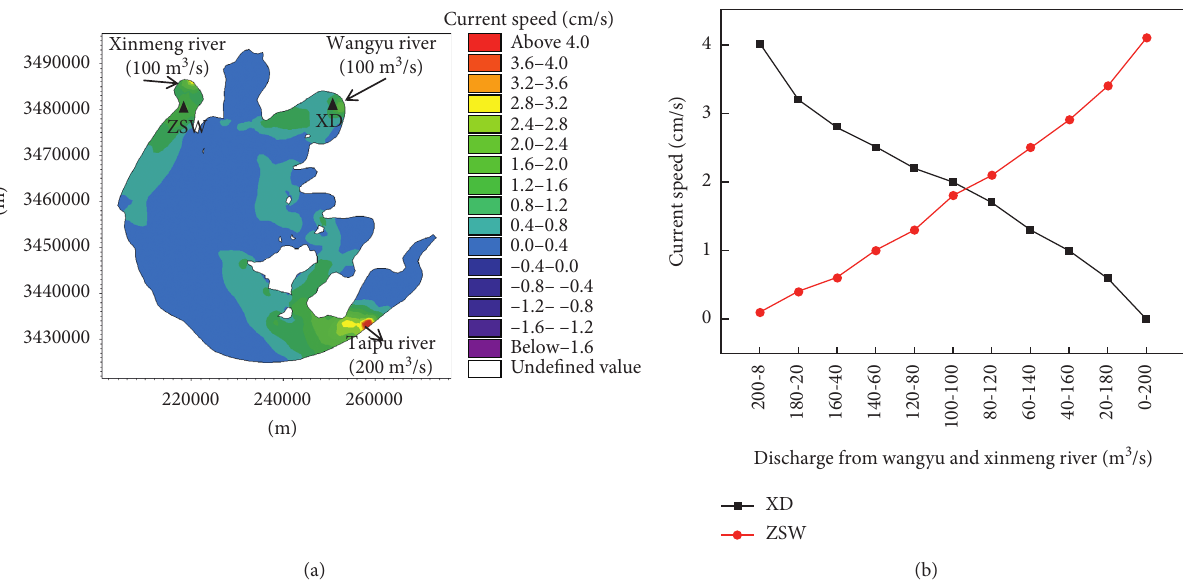
Figure 7: (a) Map of Tai Lake showing the speed of water flow, and (b) flow rates in different levels of water diversion from the Yangtze River to Tai Lake scales from the Wangyu and Xingmeng